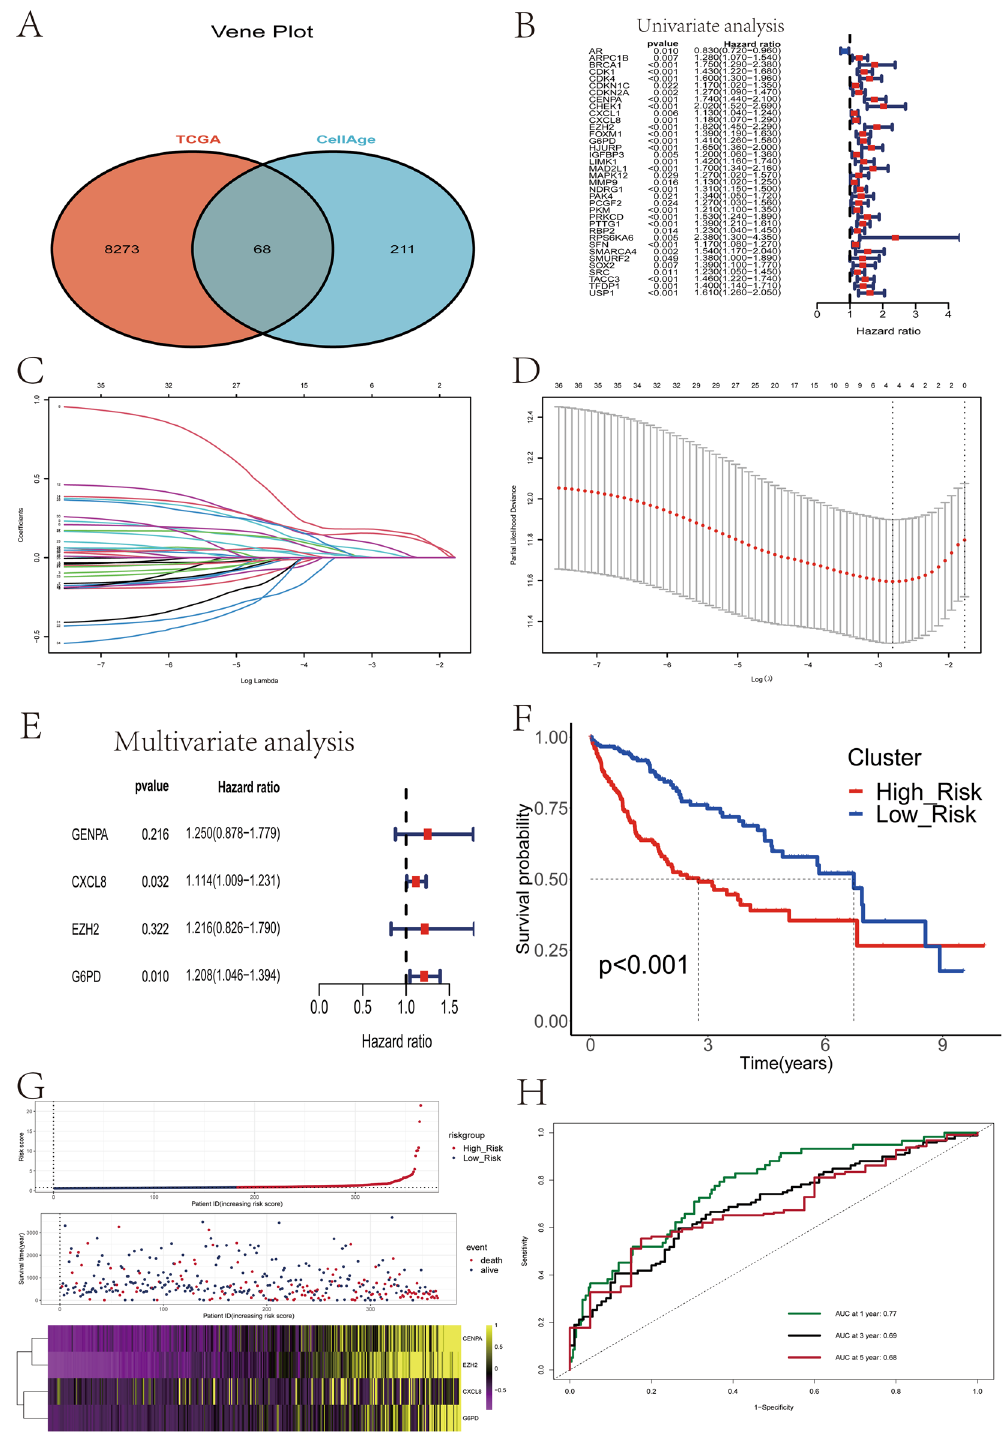
Figure 7. Construction and validation of a prognostic signature based on cellular senescence-related genes. ( A ) Venn diagram demonstrating the acquisition of 68 differentially expressed cellular senescence-related genes. ( B ) Results of univariate Cox regression analysis of differentially expressed cellular senescence-associated genes. ( C ) The coefficients of genes calculated by multivariate Cox regression using LASSO. ( D ) The partial likelihood deviance of genes. ( E ) Results of multivariate Cox regression analysis of four differentially expressed cellular senescence-related genes. ( F ) Kaplan–Meier curves were used to compare the overall survival of HCC patients between the high-risk and low-risk groups. ( G ) The association of risk scores with survival status and gene expression in HCC patients.( H ) ROC curves of the prognostic signature for predicting the risk of death at 1, 3, and 5